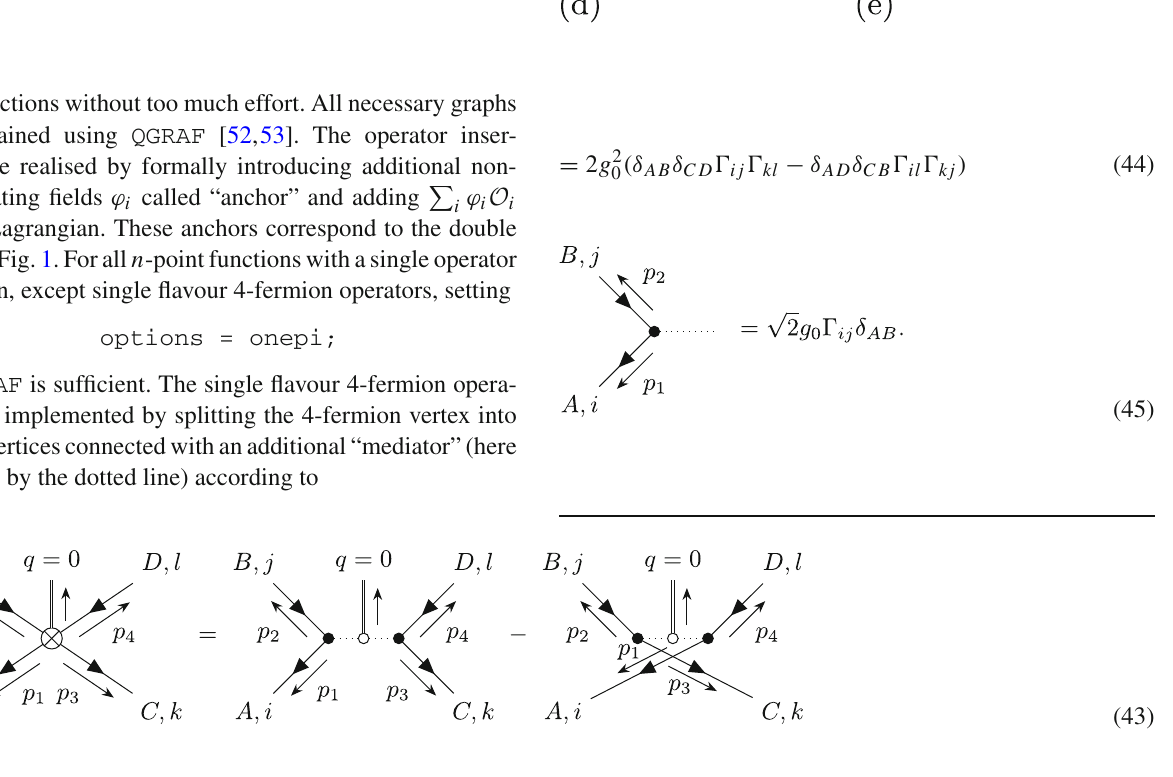
(cid:24) ϕ O i i i